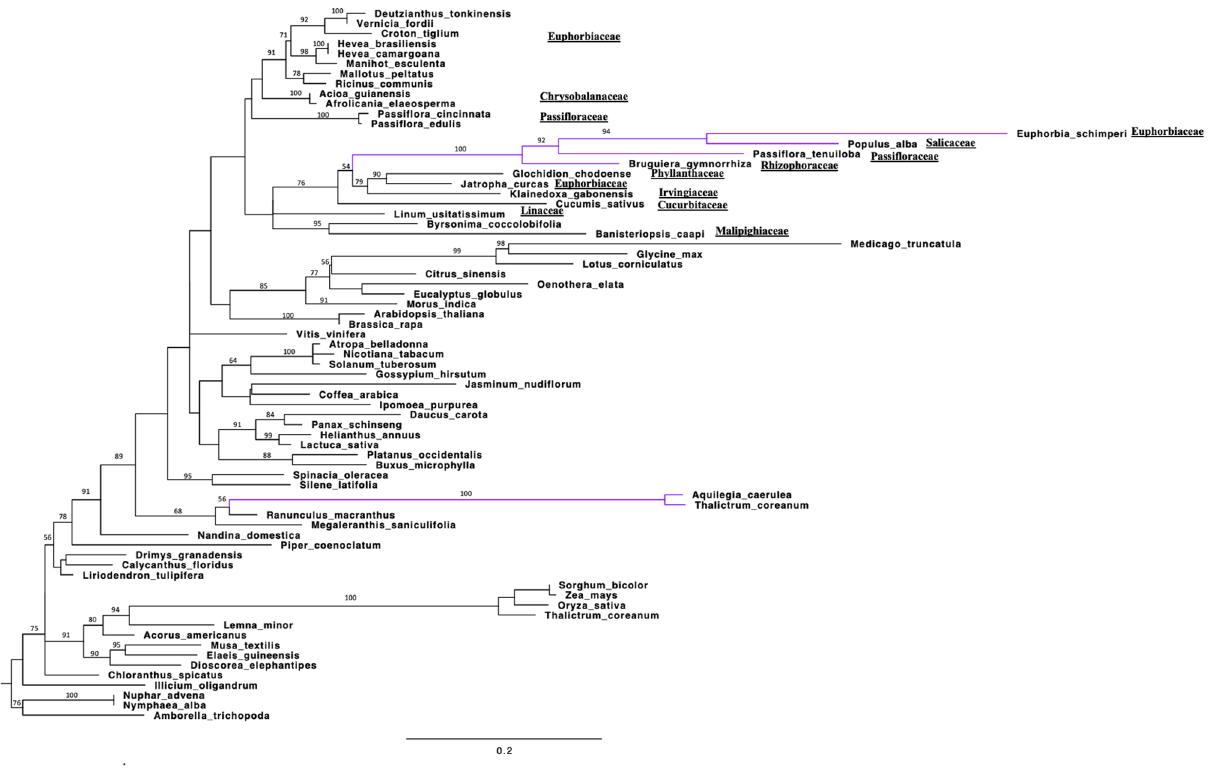
0.2 nucleotide substitutions per